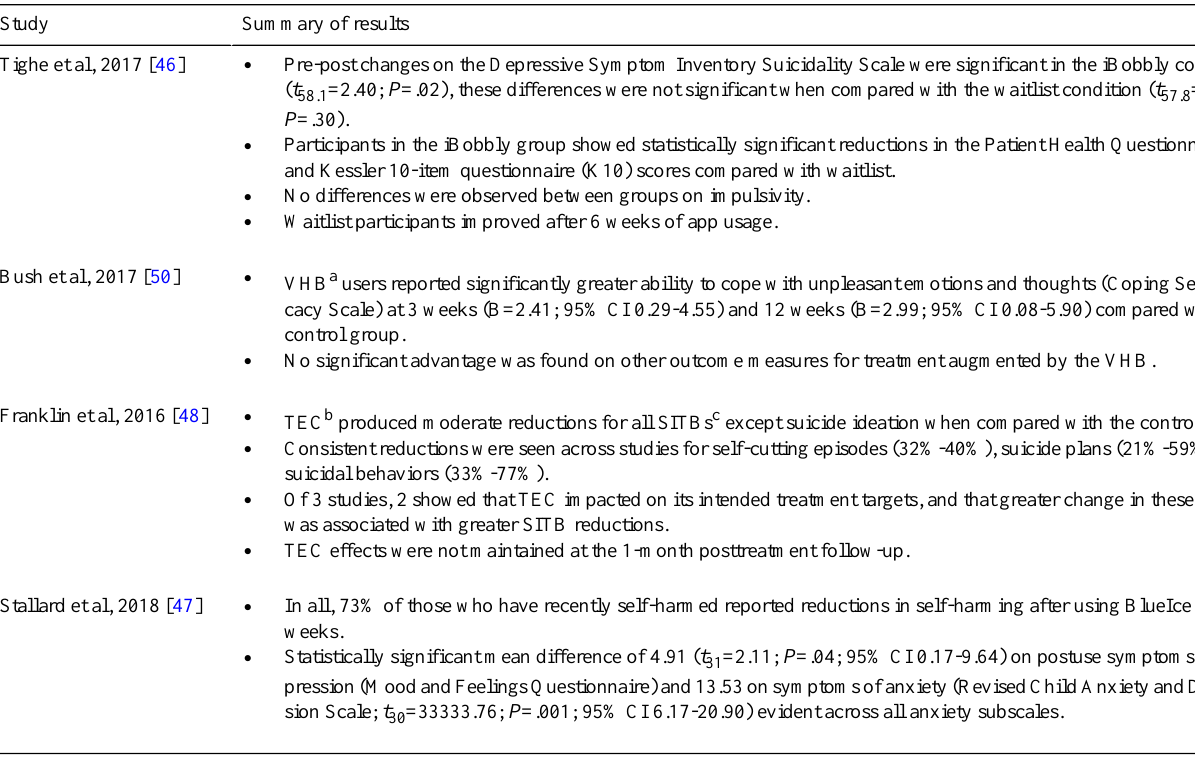
Table 1. Summary of results of published studies included. Summary of